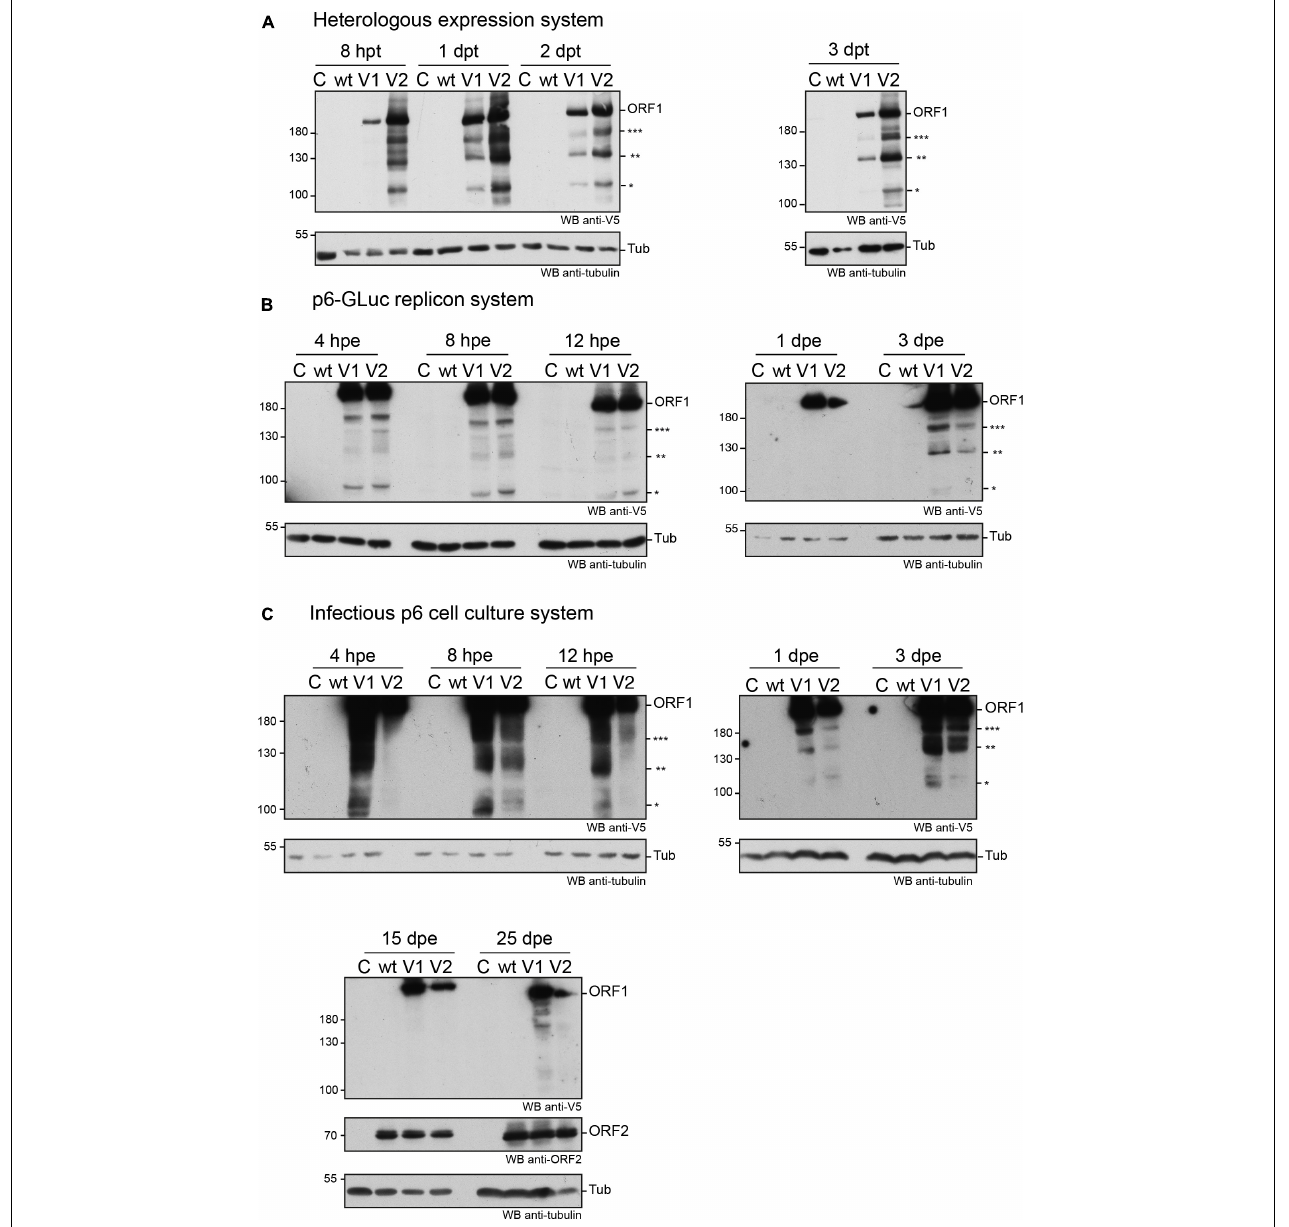
FIGURE 3 | Expression of the V5-tagged ORF1 protein over time in different cellular systems. (A) Heterologous expression of the HEV p6 ORF1 protein. H7-T7-IZ cells were transfected with a pTM plasmid expressing the wild type untagged ORF1 protein (wt) or the V5-tagged ORF1 (V1 or V2). The H7-T7-IZ cells constitutively express the T7 polymerase and the ORF1 gene lies under the control of a T7 promoter. Total cell lysates were collected in presence of protease inhibitors at 8 h post-transfection (hpt) and 1, 2, and 3 days post-transfection (dpt). Mock-transfected cells served as negative control (C). The band migrating higher than 180 kDa corresponds to the full-length ORF1 protein (ORF1). The immunoblot was probed either with an anti-V5 antibody or an anti- γ -tubulin antibody to control for even loading. Molecular weight markers are indicated in kilodaltons. Stars indicate lower molecular weight ORF1 products. (B) Expression of the ORF1 protein in the p6-GLuc replicon system. PLC3 cells were electroporated with a replicon expressing the wild type untagged ORF1 protein (wt) or the V5-tagged ORF1 (V1 or V2). Total cell lysates were collected in presence of protease inhibitors at 4, 8, and 12 hpe and 1 and 3 dpe. Mock-electroporated cells served as negative control (C). The band migrating higher than 180 kDa corresponds to the full-length ORF1 protein (ORF1). The immunoblot was probed either with an anti-V5 antibody or an anti- γ -tubulin antibody to control for even loading. Molecular weight markers are indicated in kilodaltons. Stars indicate lower molecular weight ORF1 products. (C) Expression of the ORF1 protein in the infectious p6 cell culture system. PLC3 cells were electroporated with in vitro transcribed genomic RNA of the p6 infectious strain expressing the wild type untagged ORF1 protein (wt) or the V5-tagged ORF1 (V1 or V2). Total cell lysates were collected in presence of protease inhibitors at 4, 8, 12 hpe and 1, 3, 15, 25 dpe. Mock-electroporated cells served as negative control (C). The band migrating higher than 180 kDa corresponds to the full-length ORF1 protein (ORF1). The immunoblot was probed either with an anti-V5 antibody or an anti-ORF2 (1E6) antibody or an anti- γ -tubulin antibody to control for even loading. Molecular weight markers are indicated in kilodaltons. Stars indicate lower molecular weight ORF1 products.